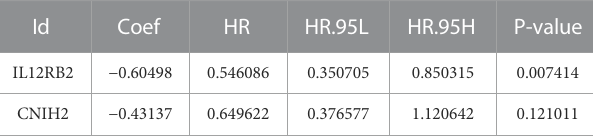
TABLE 4 mRNAs were obtained from multivariate Cox regression analysis.